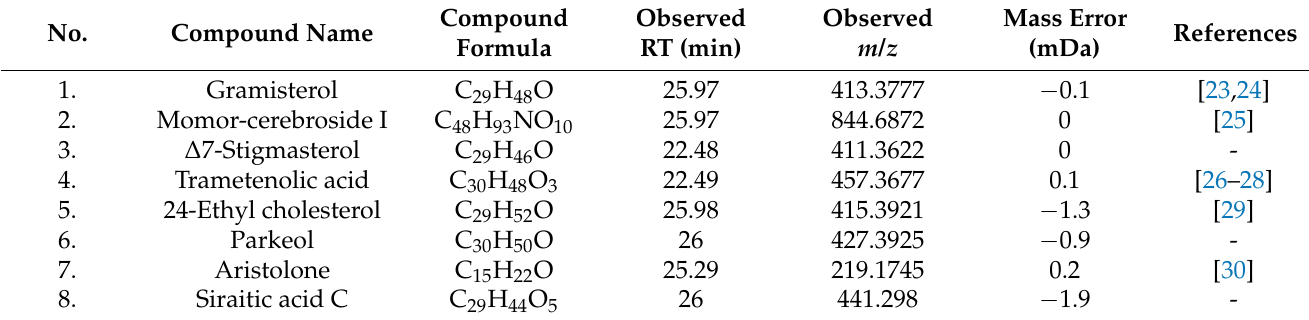
Table 2. LC-QTOF analysis ethanol extract of A. santolinifolia